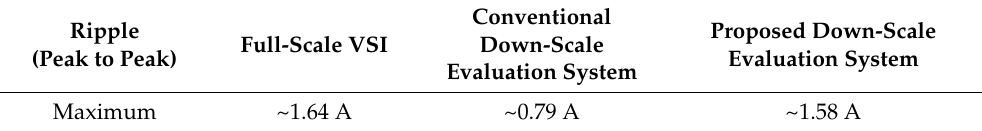
Figure 7. Simulation ( left ) and corresponding experimental ( right ) waveforms of output three-phase voltages V a , V b , V c and output current i a under ( a , d ) full-scale VSI with output inductor 2 mH, ( b , e ) conventional down-scale voltage rating evaluation system with output inductor 2 mH, and ( c , f ) proposed down-scale voltage rating evaluation system with output inductor 1 mH. Table 3. Comparison of simulated line-current ripple at maximum phase voltage.